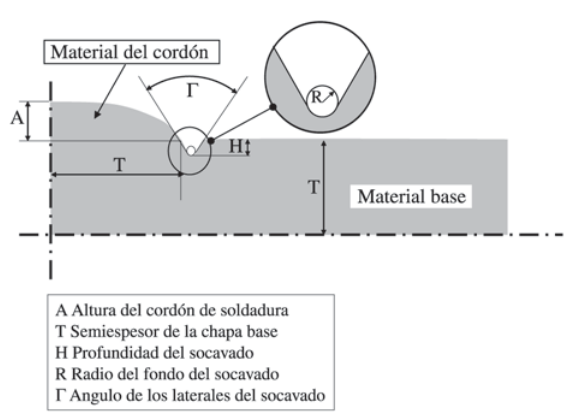
Figura 1. Geometria simplificada del cordón de soldadura.